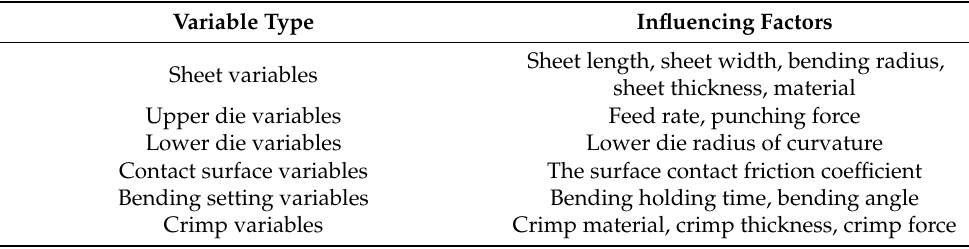
Table 2. Influencing factors of springback.